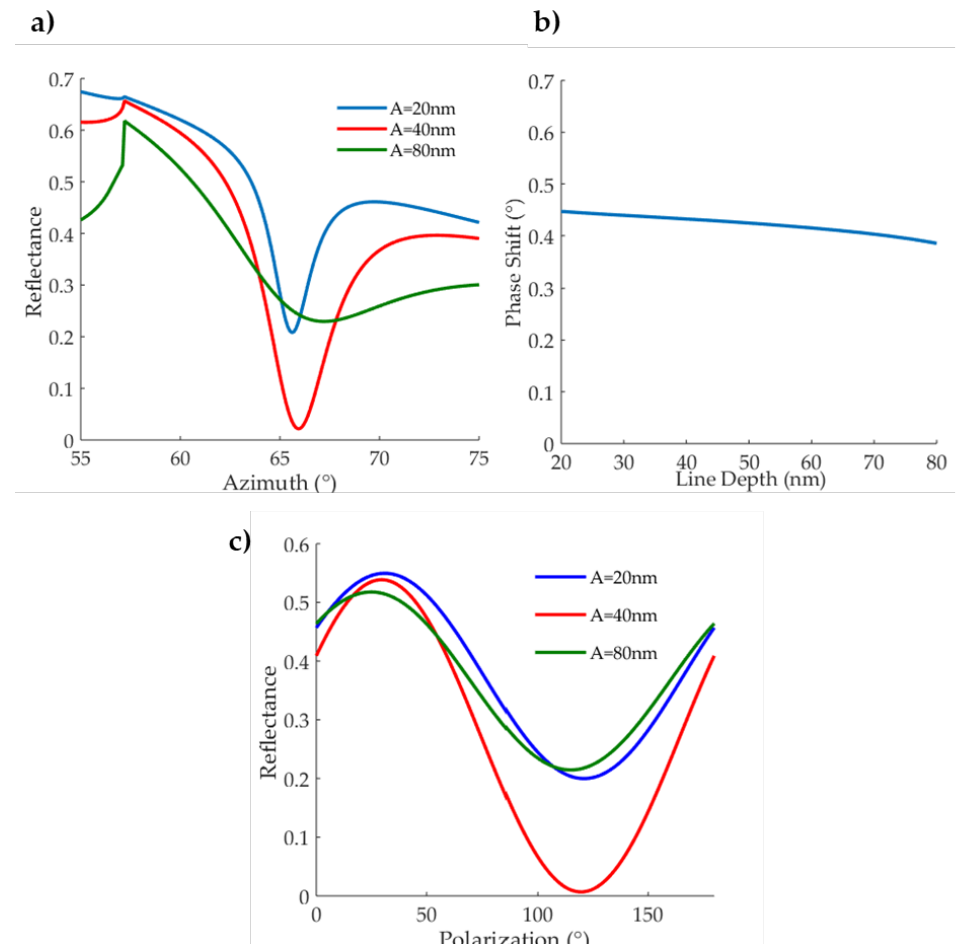
Figure 2. Grating line depth numerical analysis. ( a ) Azimuthal spectrum for 400 nm gratings at 633 nm wavelength at 60° incidence, for different grating line depths: A = 20 nm, A = 40 nm and A = 80 nm (see figure colour legend). ( b ) Phase shift dependence on grating line depth at 60° polar angle, 633 nm wavelength at the corresponding resonance azimuth, for a refraction index of 0.002 from pure water. ( c ) Simulated polarization spectra in water for different grating line depth at resonance. The minimum reflectance is achieved with gratings of 40 nm depth.